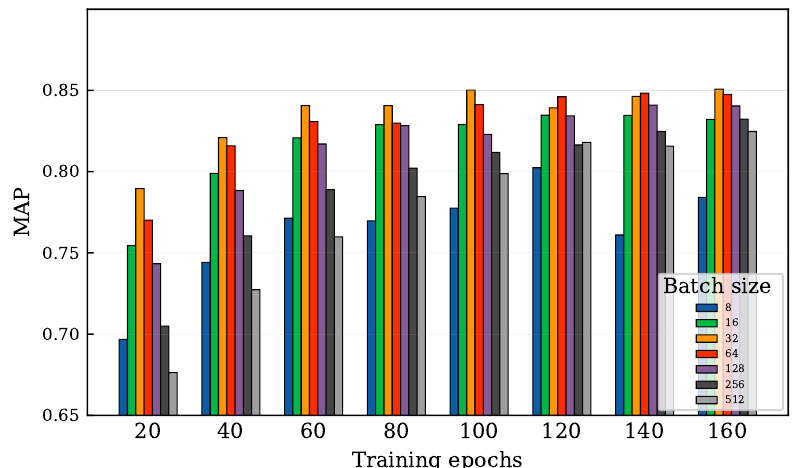
Figure 11. Our proposed model trained with different batch size and